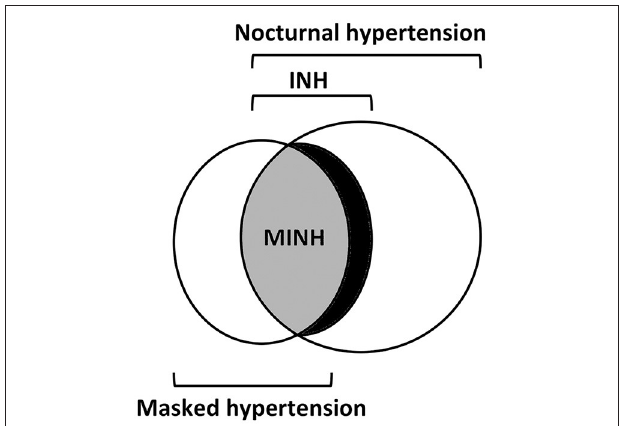
FIGURE 1 | The overlap between subjects with nocturnal hypertension, isolated nocturnal hypertension, masked isolated nocturnal hypertension, and masked hypertension. More than one-third of the subjects with nocturnal hypertension had isolated nocturnal hypertension (INH) . INH consists largely of masked INH (MINH) . Masked hypertension, on the other hand, is largely attributed to